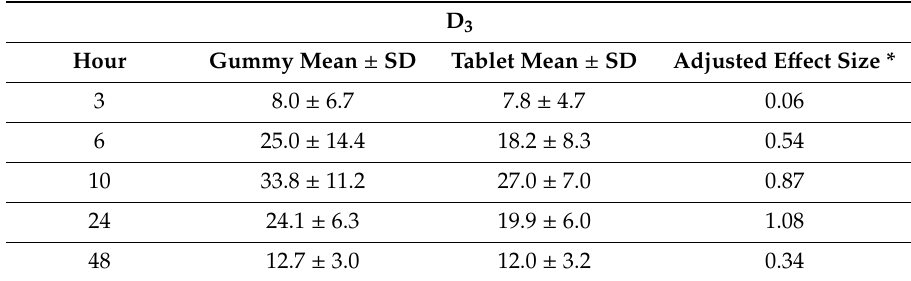
Table 3. Study 1 ( n = 9). Mean ± SD changes from baseline vitamin D 3 blood concentrations (ng / mL) at each time point measured.